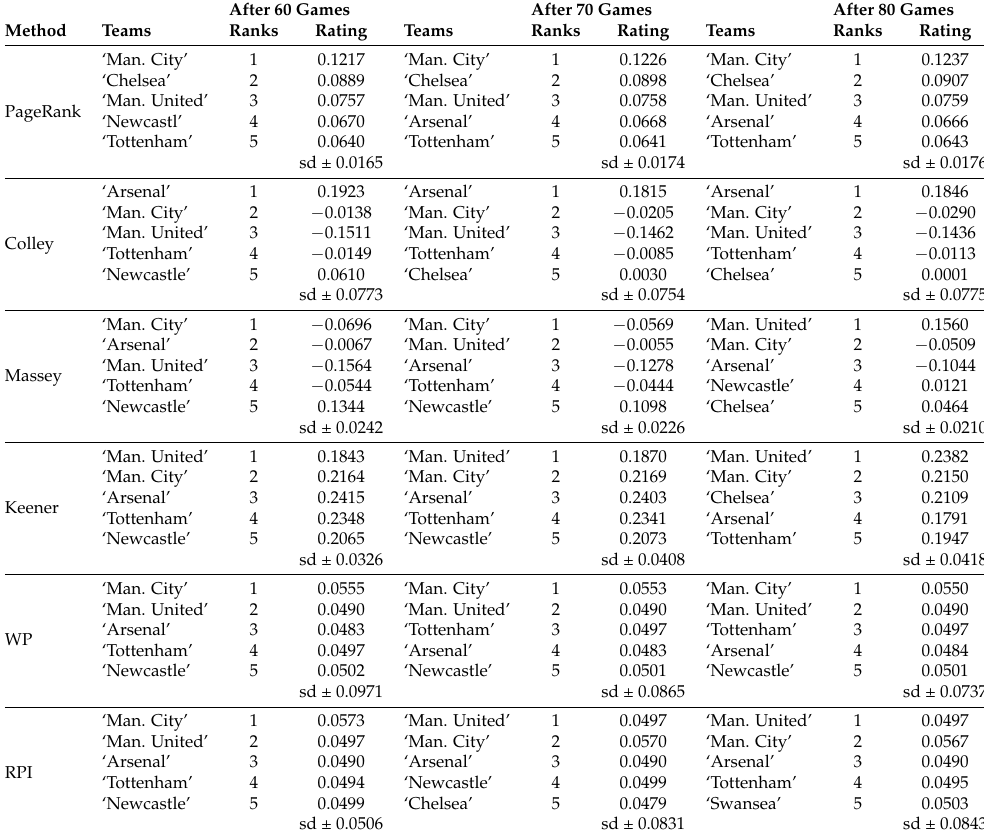
Table 2. Comparison of top-5 teams rate–rank by expanding window